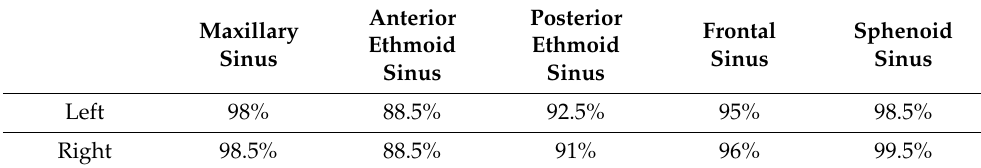
Table 6. Doctors’ grading results.